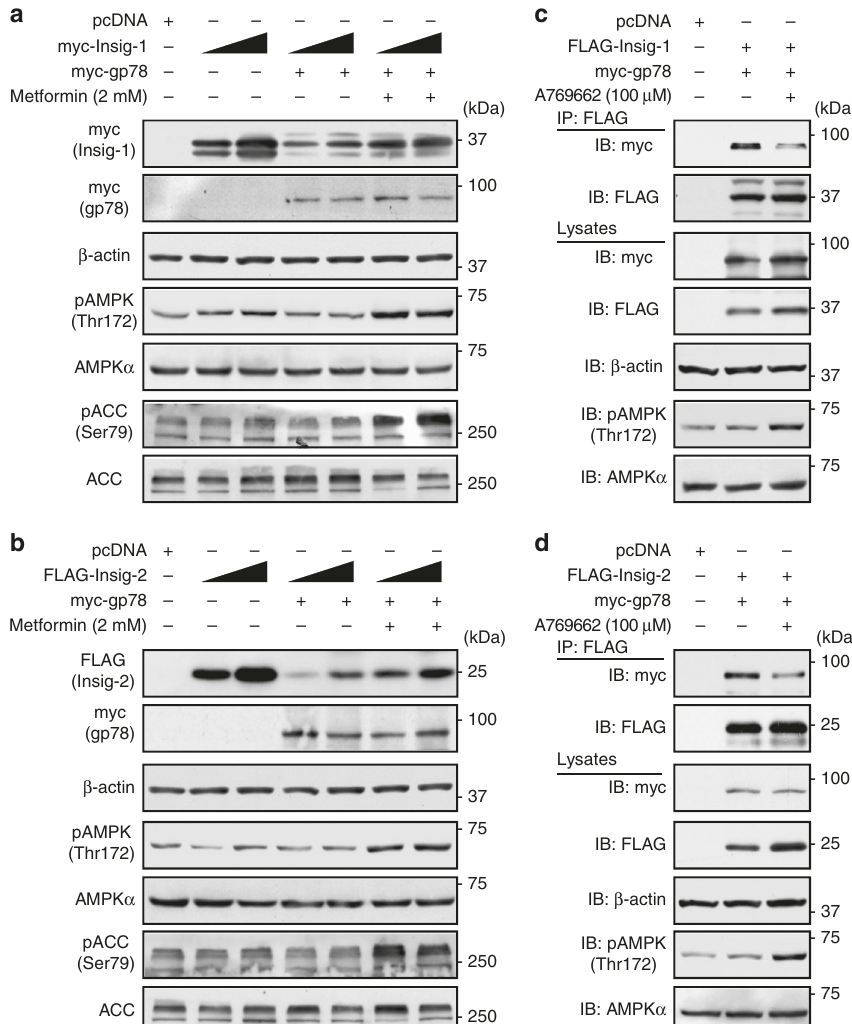
Fig. 4 Activation of AMPK ablates the interaction between Insig and the ubiquitin ligase gp78. a , b Metformin reverses the gp78-mediated degradation of Insig-1 ( a ) and Insig-2 ( b ). myc-Insig-1 or FLAG-Insig-2 was co-transfected with myc-gp78 in HEK293 cells for 24 h, followed by treatment with 2 mM metformin for 24h. Immunoblots were performed. c , d AMPK-speci fi c agonist A769662 inhibits the interaction between Insig and gp78. FLAG-tagged Insig-1 ( c ) or Insig-2 ( d ) was co-transfected with myc-tagged gp78 in HEK293 cells for 24 h, followed by treatment with 100 μ M A769662 for 8 h. The cell lysates were incubated with FLAG antibodies and puri fi ed with protein A/G-Sepharose beads. The precipitates and lysates were individually immunoblotted with indicated